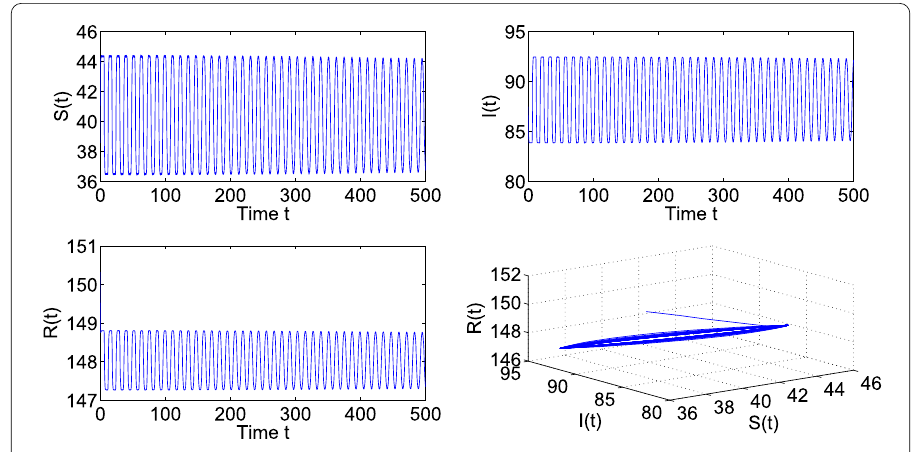
Figure 3 System (45) under goes a Hopf bifurcation when τ 1 = 3.750 > τ 10 = 1.9565